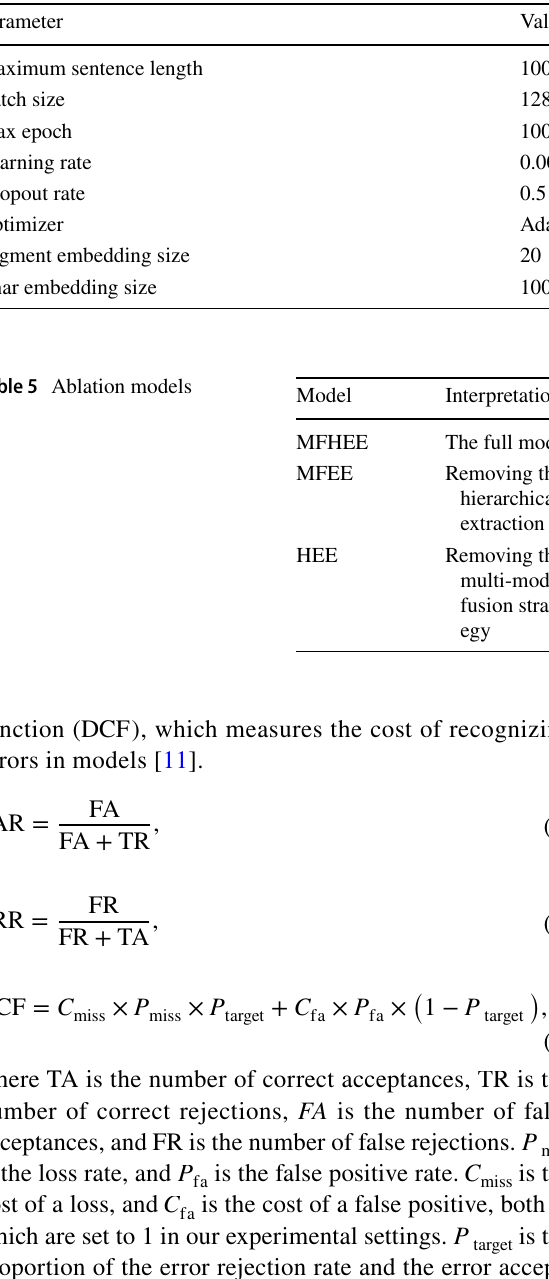
Table 4 Hyper-parameters for MFHEE model